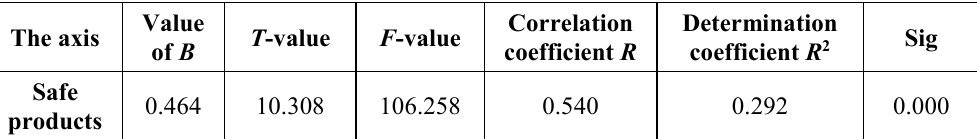
Table 4. Result of Simple Regression Analysis to Test the Impact of Safe Products on Customer Loyalty Correlation Determination Value F -value T -value The axis coefficient R coefficient R 2 of B